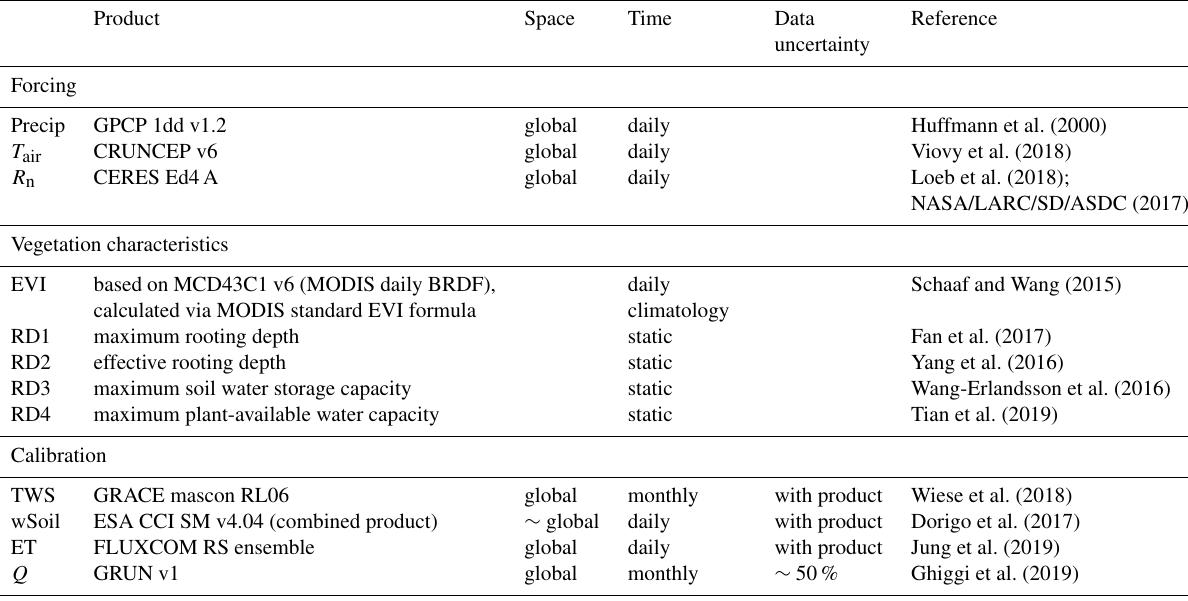
Table 1. Data used for model forcing, for description of vegetation characteristics, and for model calibration. Product Space